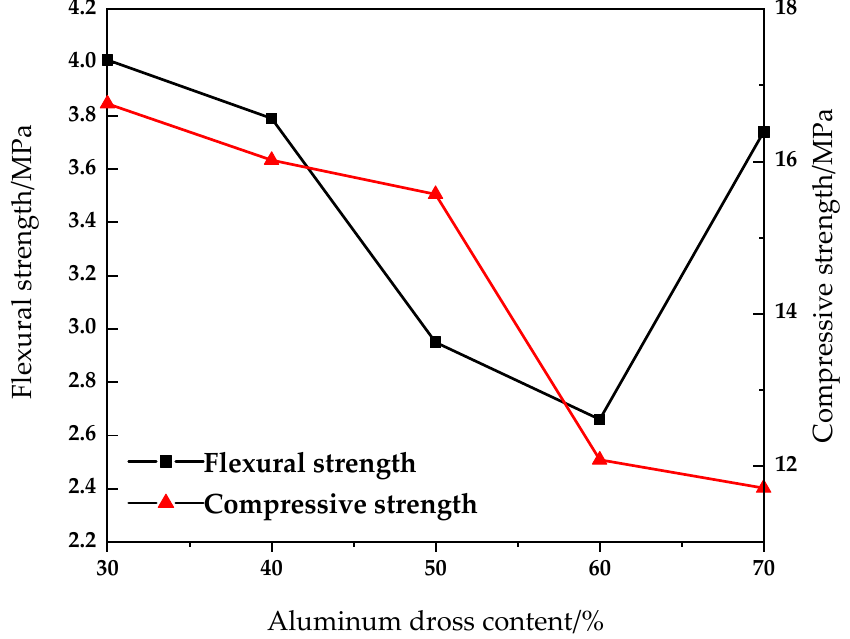
Figure 5. Effect of aluminum dross content on compressive and flexural properties of sintered brick.